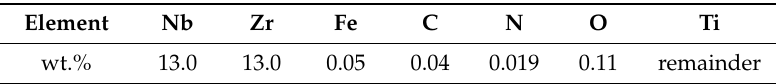
Table 1. The chemical composition of the Ti13Zr13Nb alloy, wt.%.